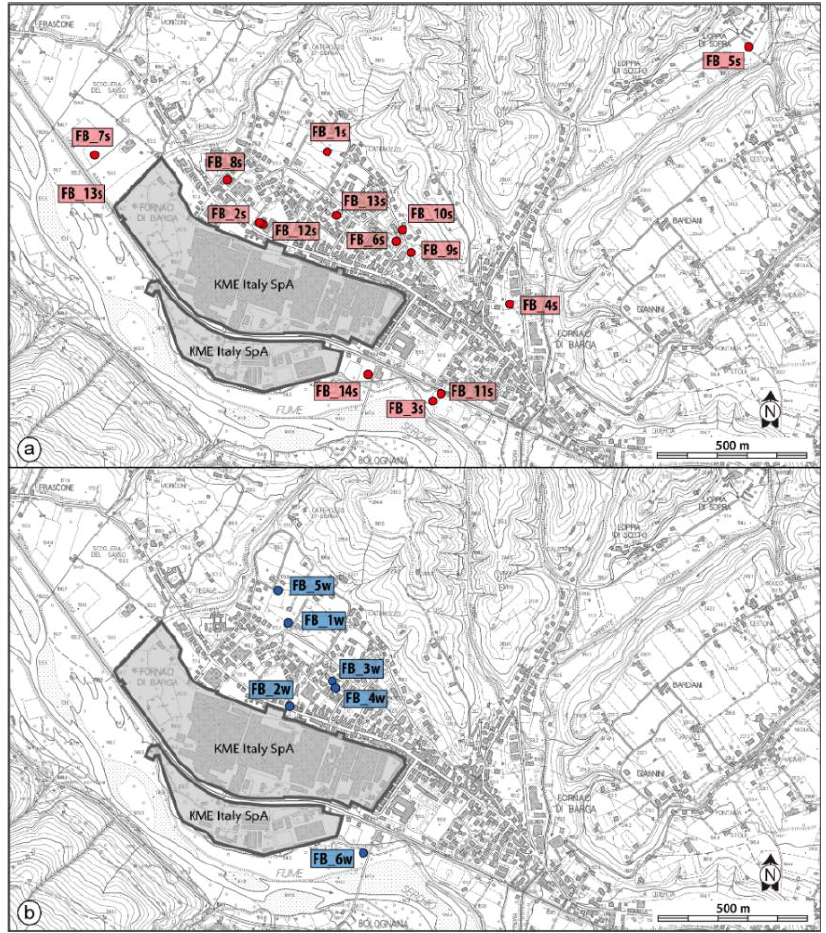
Figure 2. Location of soil ( a ) and groundwater ( b ) sampling stations. Groundwater was sampled in the unconfined aquifer of Fornaci di Barga on July, 2020 through five wells tapping groundwater bodies at different depth (FB_1W, depth 50 m; FB_2W, depth 8 m; FB_3W, depth 7 m; FB_4W, depth 18 m; FB_5W, depth 21 m) and in a piezometer nearby the station FB_14S, using a bailer at depth of 3.5 and 8.7 m below ground level (samples FB_6Wa and FB_6Wb, respectively). The georeferenced distribution of groundwater sampling stations is shown in Figure 2b. Water samples were filtered in the field through 0.45 µ m filters and refrigerated in pre-cleaned polyethylene bottles. Ultrapure nitric acid was used as a preservative for major cation and trace element